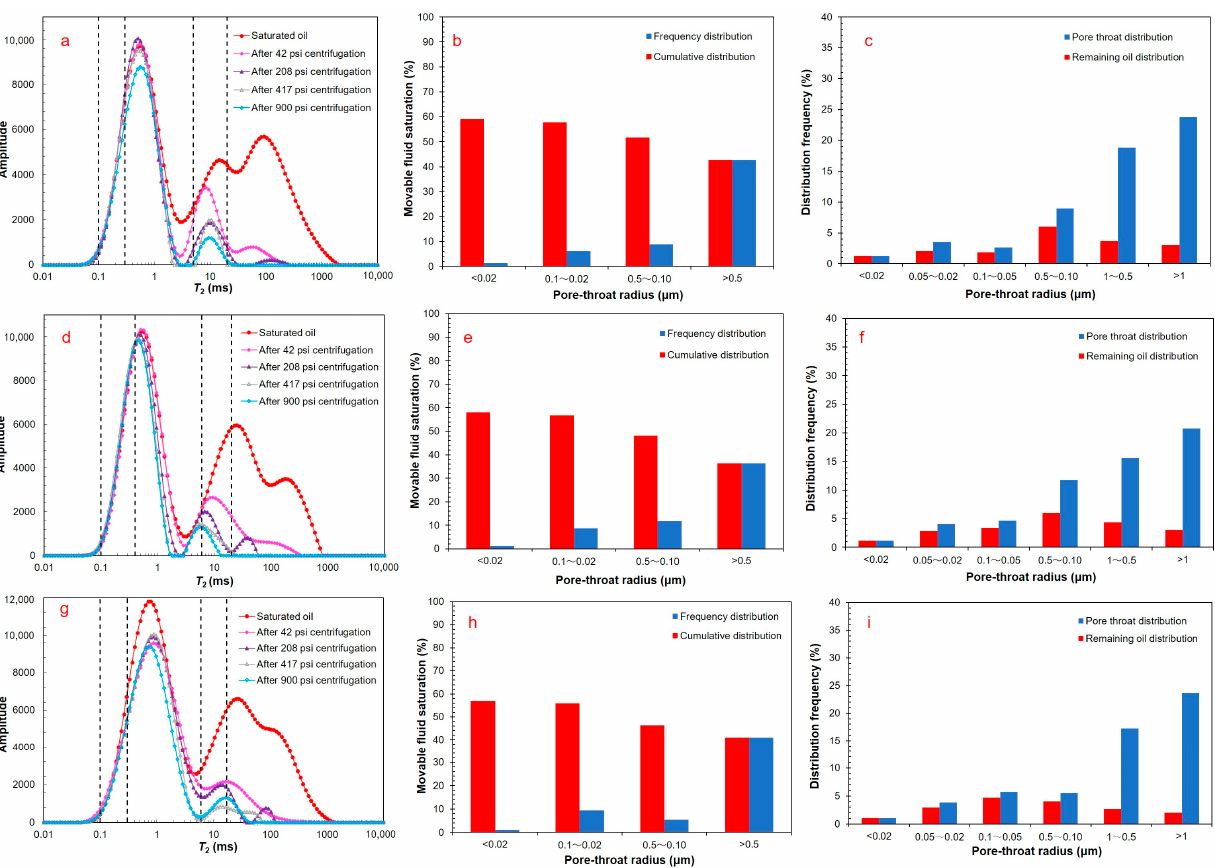
Figure 6. Centrifugal NMR results of core samples of type Ⅰ reservoir; ( a , d , g ) are the T 2 spectrum of centrifugal NMR of CD-3, CD-4 and CD-10, respectively; ( b , e , h ) are the throat radius distribution frequency diagram of CD-3, CD-4 and CD-10, respectively; ( c , f , i ) are the frequency distribution of residual oil in pore space of different scales of CD-3, CD-4 and CD-10, respectively. CD-2, CD-5 and CD-7 belong to type II reservoirs. The T 2 spectrum of the type II reservoirs show a bimodal distribution in the saturated oil state, indicating the reduction of large pore throats (Figure 7a,d,g). The T 2 cutoff values of the effective pore, movable fluid pore and movable crude oil pore are 0.4 ms, 10.0 ms and 18.0 ms, respectively. For the type II reservoir, the distribution frequencies of pore throat radii >0.1 µ m, 0.1–0.02 µ m and <0.02 µ m are 37.8%, 11.2% and 1.87%, respectively (Figure 7b,e,h). The crude oil in the pore throats greater than 0.1 µ m has the highest production degree of 73.6%. The